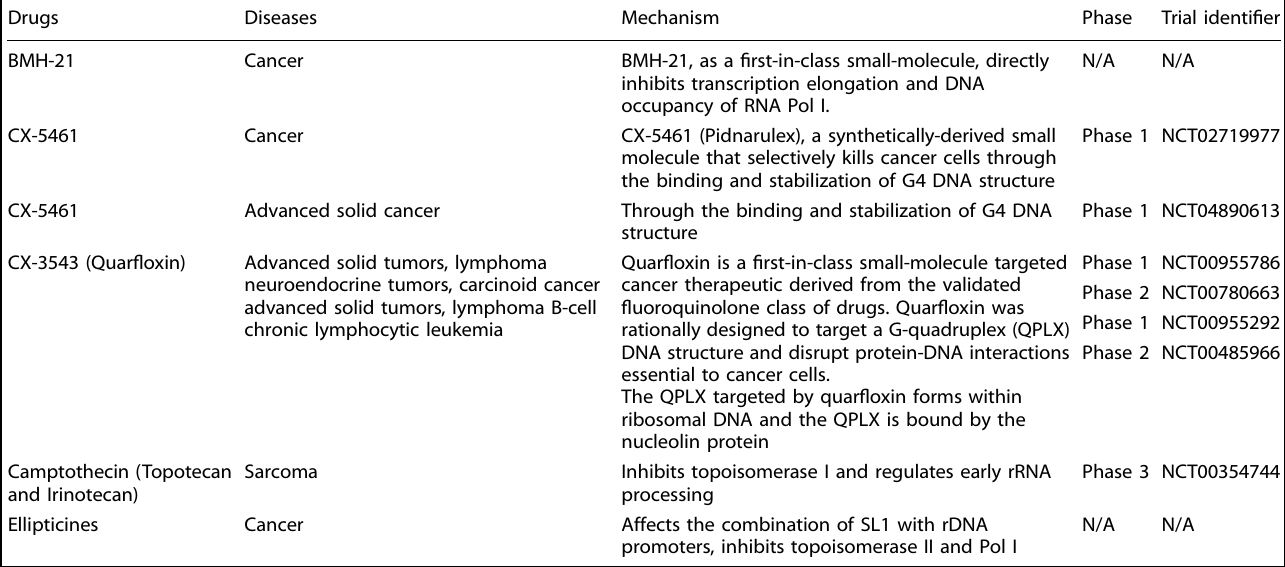
Table 2. Clinical trials targeting cancer and ribosome biogenesis Drugs